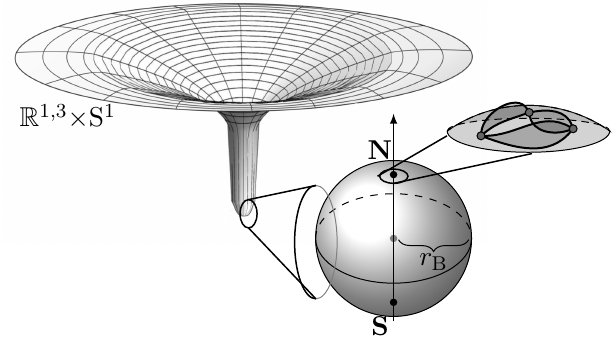
Figure 3 . Schematic description of a generic topological